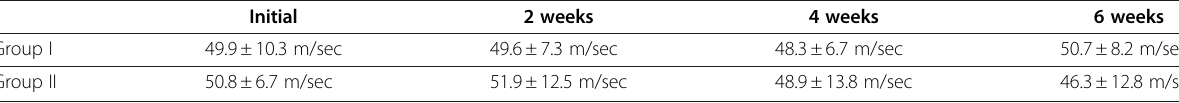
Table 2 H-reflex related sensory nerve conduction velocity in rats